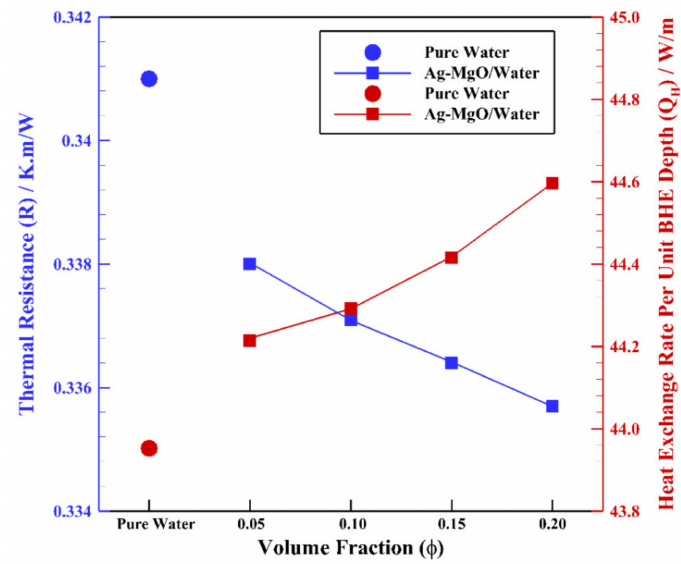
Figure 12. The total thermal resistance of the borehole and the surrounding soil and the heat exchange rate per unit BHE depth for Ag-MgO/water hybrid nanofluid with different volume fractions at Re = 3200.